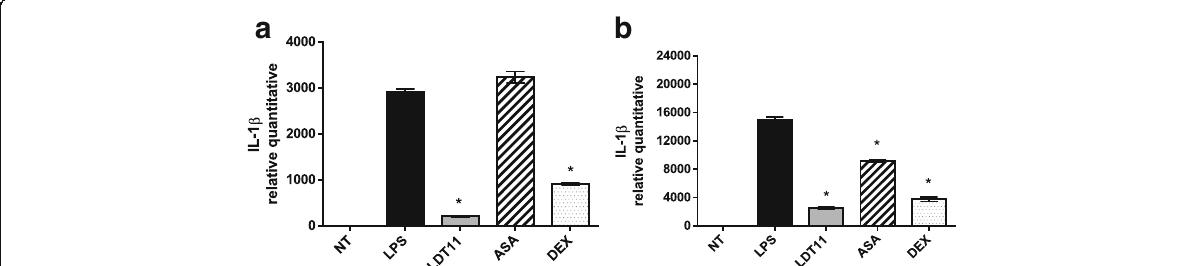
Fig. 9 Determination of the relative amount of IL-1 β gene transcripts in RAW 264.7 cell line for the evaluation of inflammatory response at 6 ( a ) and 24 h ( b ) post-stimulus. NT- untreated cells; LPS - LPS-stimulated cells; LDT11 - cells treated with LDT11 and then with LPS; AAS - cells treated with commercial acetylsalicylic acid and then with LPS; DEX - cells treated with the commercial anti-inflammatory Dexamethasone and then with LPS. All data are from at least three independente experiments, * p < 0.05, statistically different compared with cells LPS-stimulated